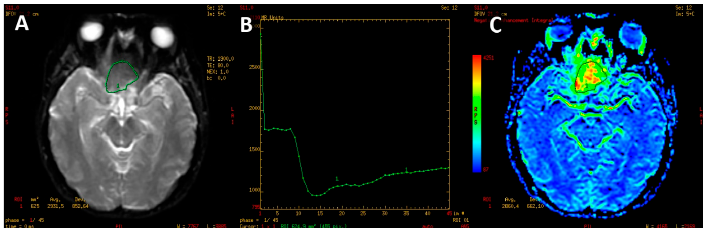
Figure 2. PWI image of macroadenoma ( A ). T2* signal intensity curve ( B ) with marked decline of signal intensity during the fi rst pass on contrast agent with slow, partial return to the baseline. Color-coded map of cerebral blood volume ( C ). High CBV is presented as yellow and red colors.